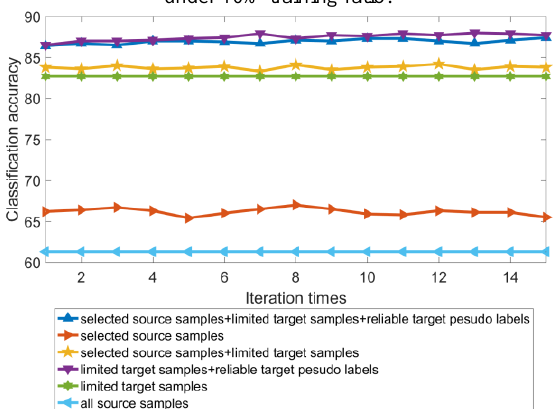
Figure 11. The experimental results of VGG-16 architecture under 10% training ratio.